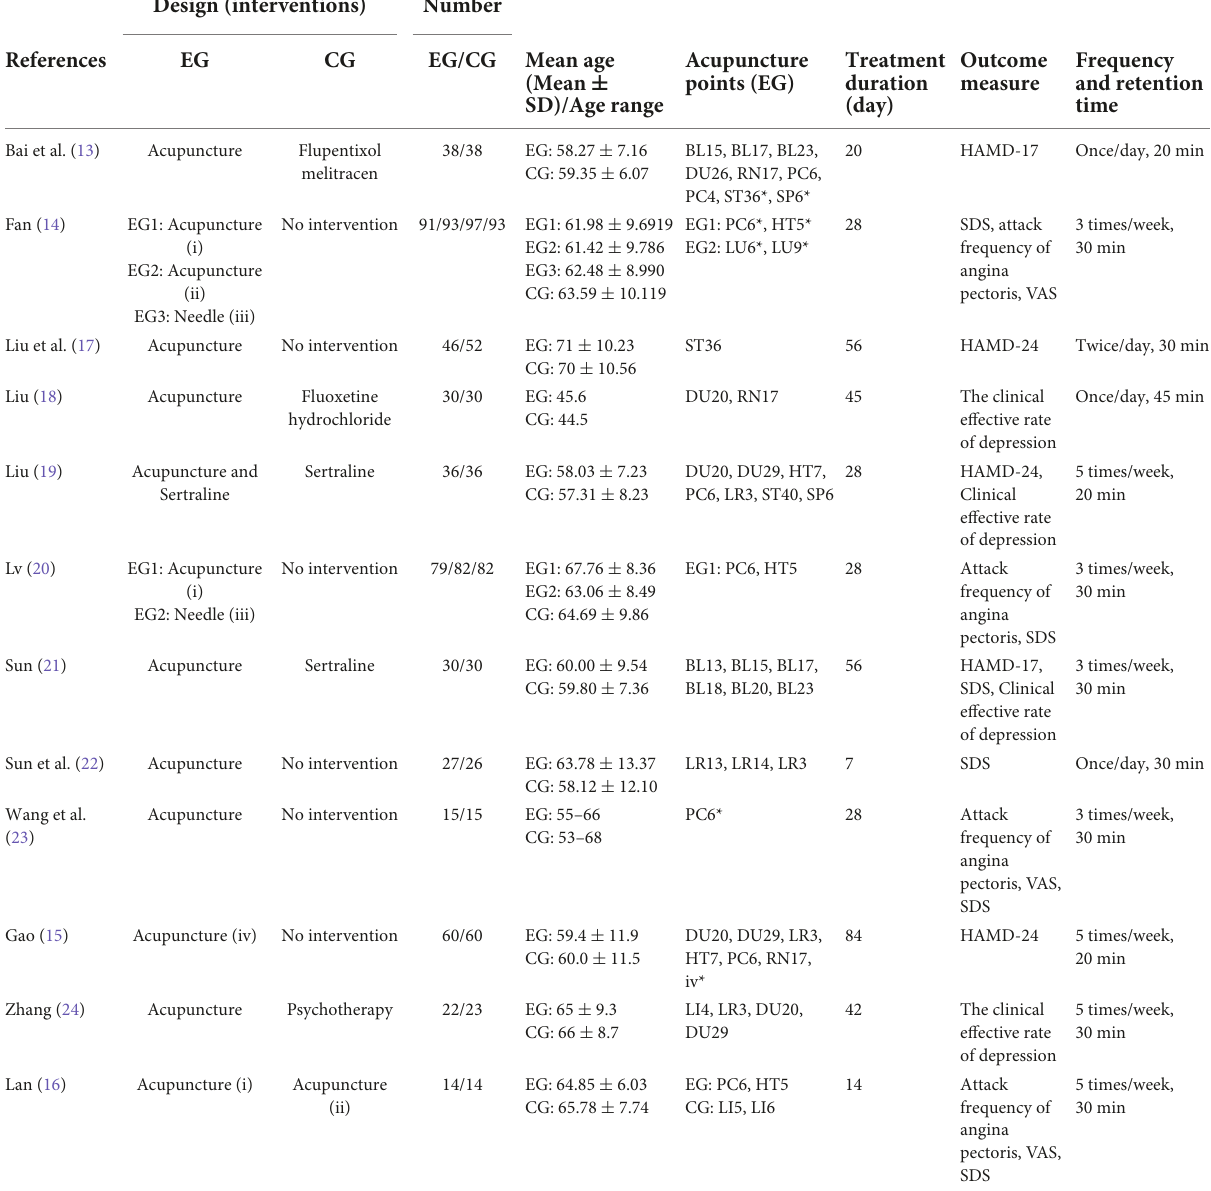
TABLE 1 Characteristics of included